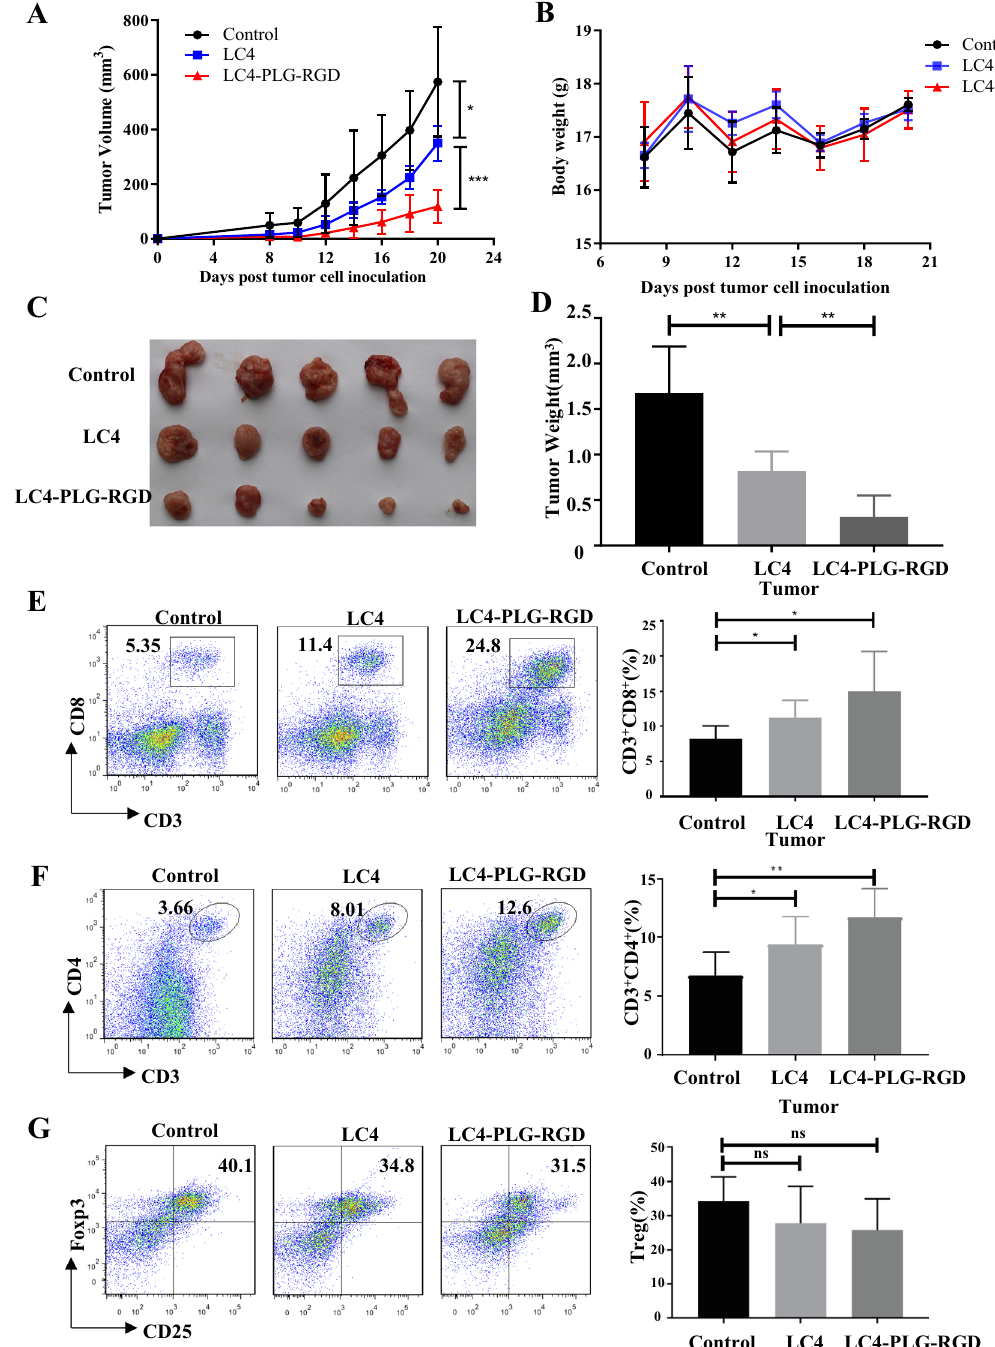
Fig. 7 LC4-PLG-RGD inhibit CT26 tumour growth by improving targeting ability. CT26 tumour-bearing mice model was established, tail vein administration, for 14 days. A – D Statistics of The A tumour volumes, B body weight, C tumour sizes, and D tumour weight of LC4- PLG-RGD, LC4 and control group. E – G The percentage of E infiltrating CD8 + T cells, F infiltrating CD4 + T cells and G infiltrating Treg cells in the tumour. Data are expressed as the mean ± SD (n = 5) and statistical significance between groups was determined by Student’s t test: * p < 0.05, ** p < 0.01, *** p < drug without Fc segment, which will not cause ADCC effect in vivo, but LC4 can cause CD8 + T cell chemotaxis, which means its mechanism needs to be further studied.